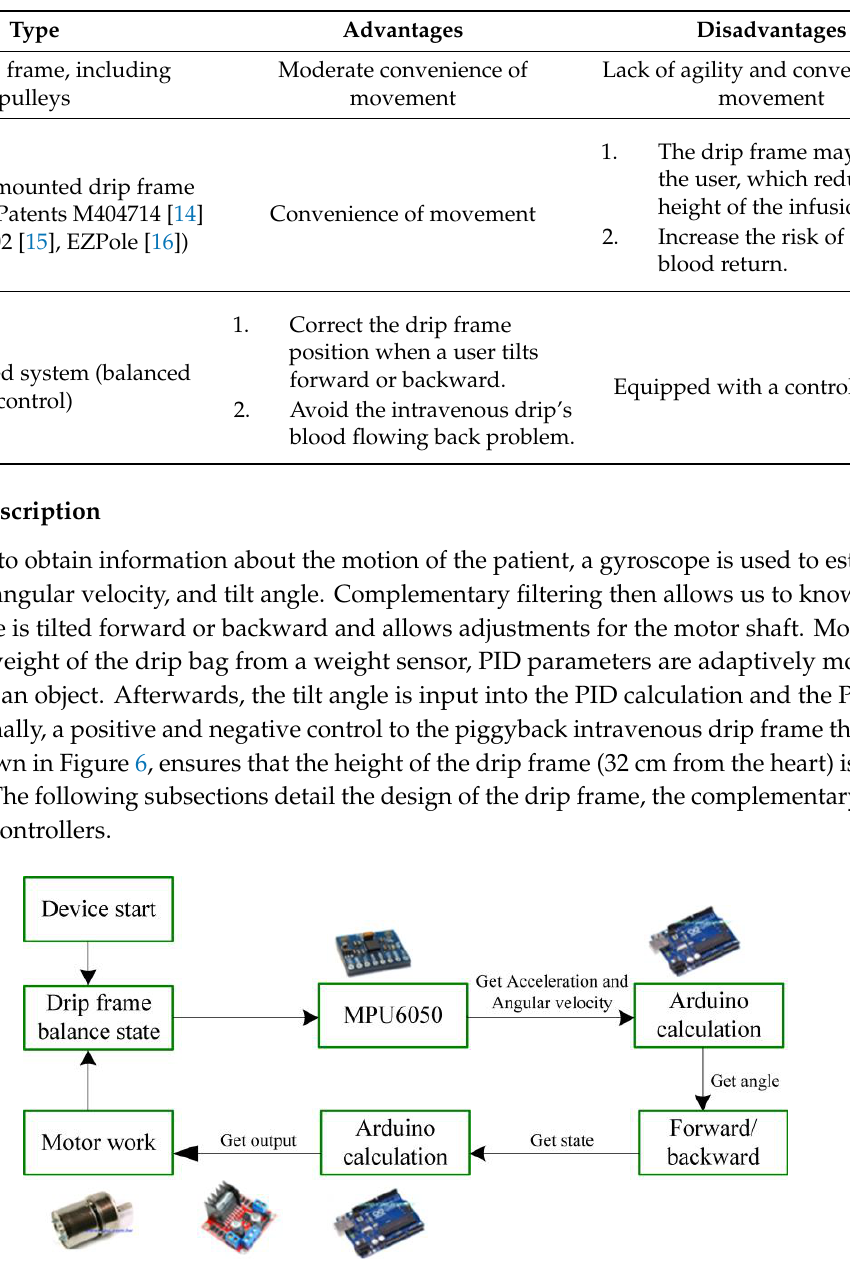
Table 1. Comparison of drip frame technologies.